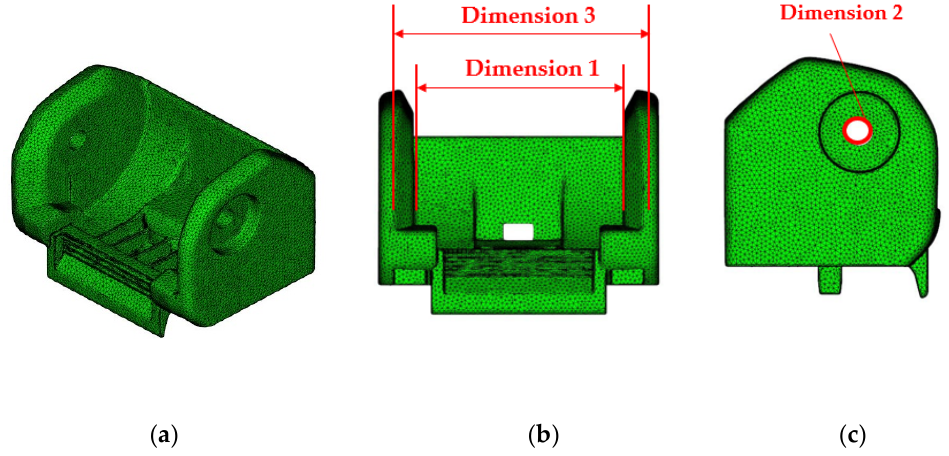
Figure 1. The shape of pivot sub-assembly. ( a ) Overview of pivot sub-assembly. ( b ) Front view of the pivot sub-assembly and location of dimensions 1 and 3. ( c ) Side view of the pivot sub-assembly and location of dimension 2.